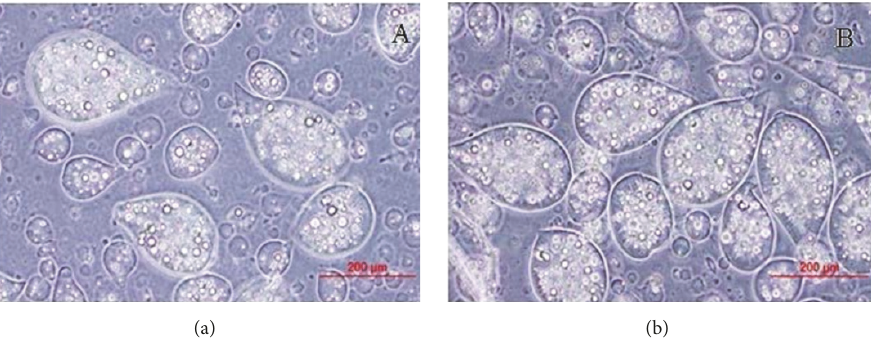
Figure 3: Microcapsule morphology under light microscope incubated in cell culture medium at 37 ∘ C on day 0 (a) and day 30 (b).